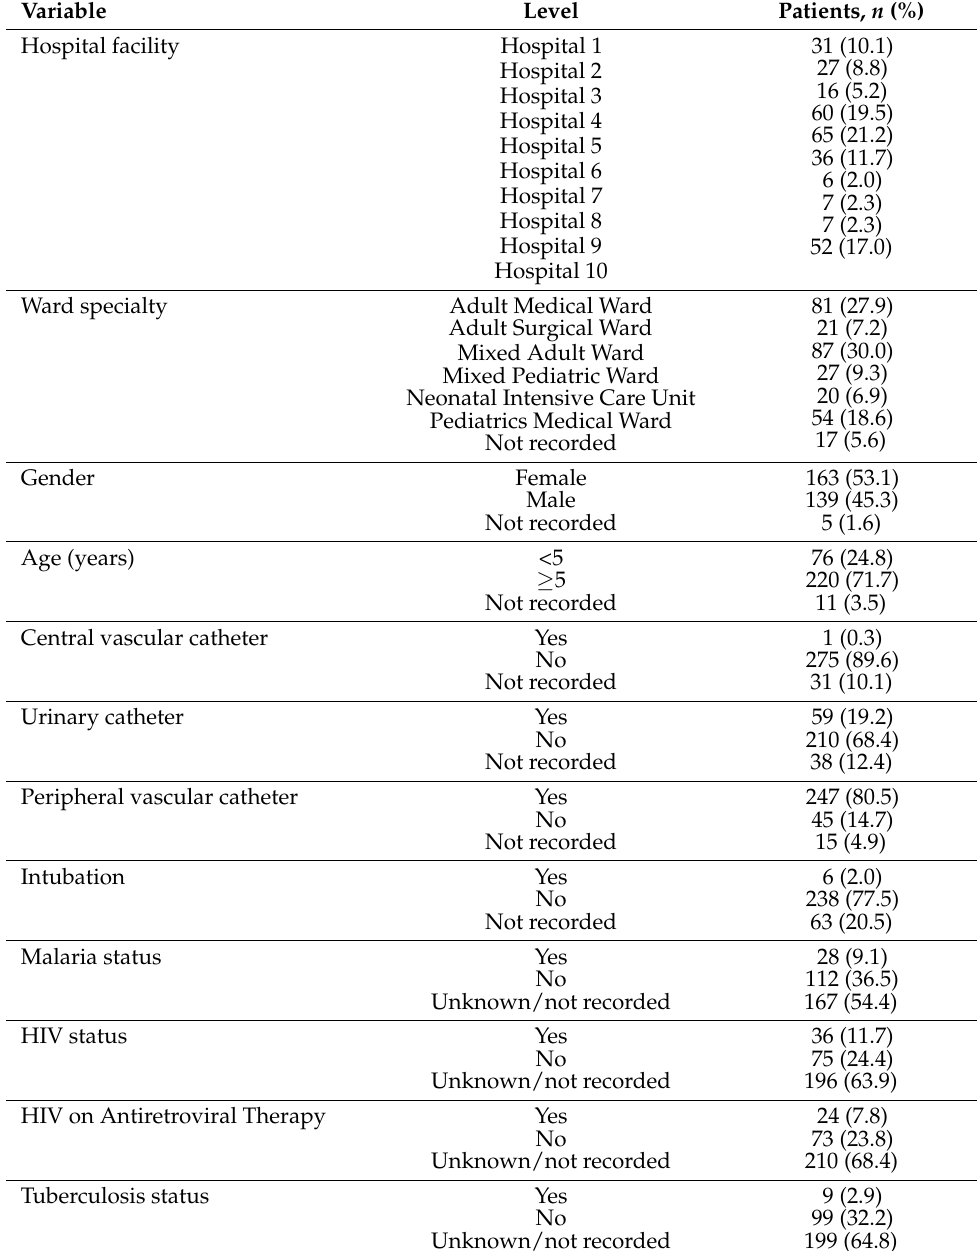
Table 1. Demographics of patients prescribed antibiotics across all surveyed hospitals ( n =